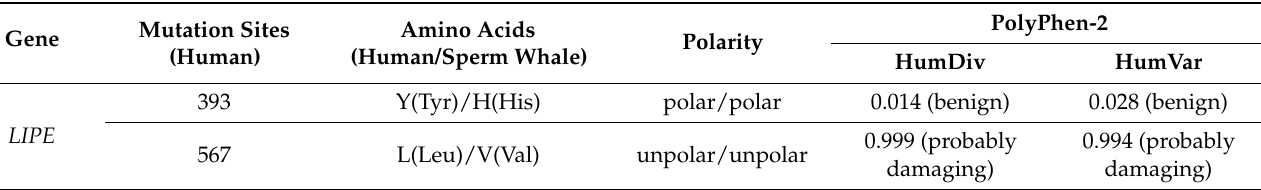
Table 2. Sperm-whale-specific missense mutations in